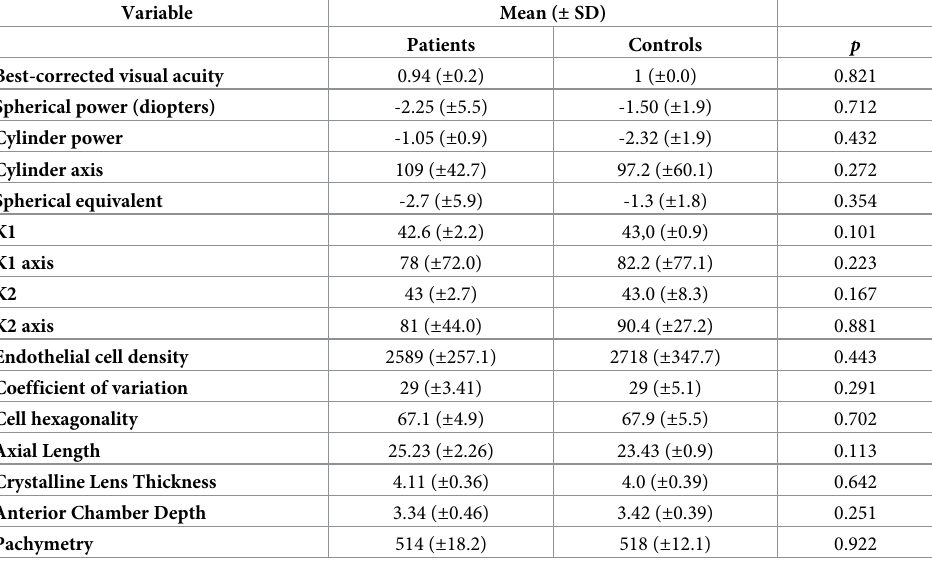
Table 3. Ocular variables: Anterior segment and biometric